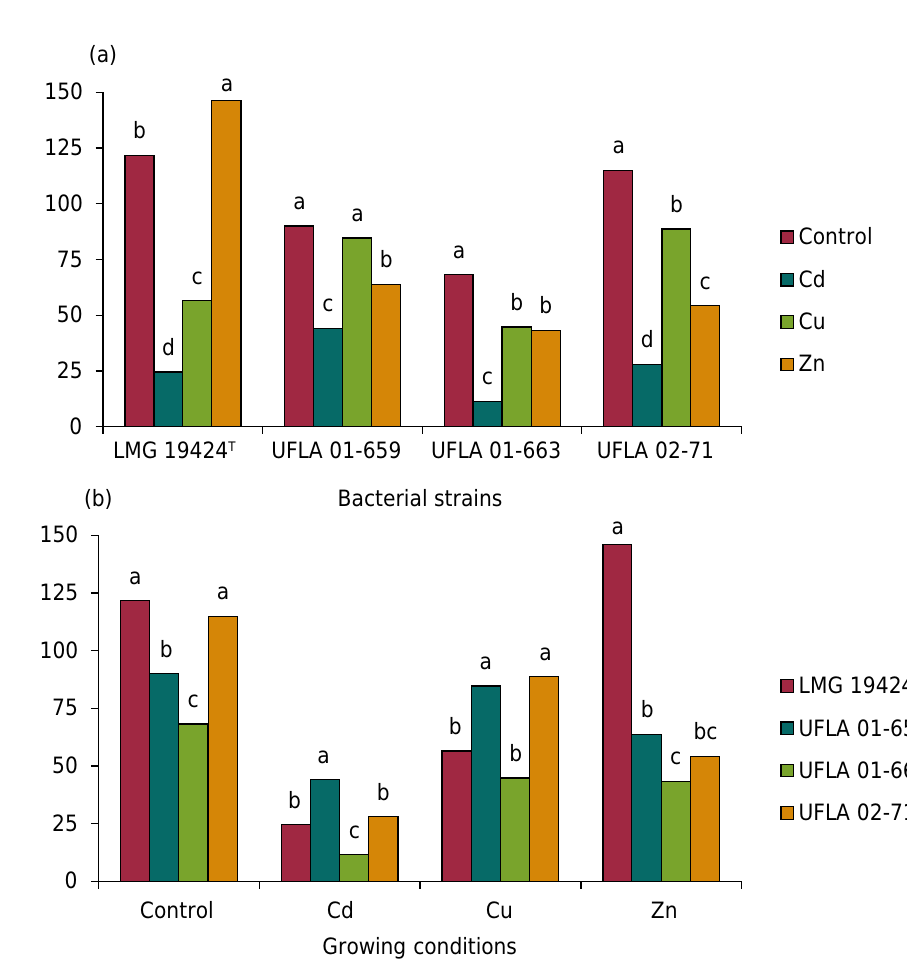
Figure 1. Biomass of bacterial strains (LMG 19424 T , UFLA 01-659, UFLA 01-663, and UFLA 02-71) cultured in the absence of metals (control) and in the presence of the metals Cd (1 mmol L 1 ) and Cu and Zn (2 mmol L -1 ) in liquid LB culture medium. Mean values followed by the same letter do not differ from each other by the Tukey test